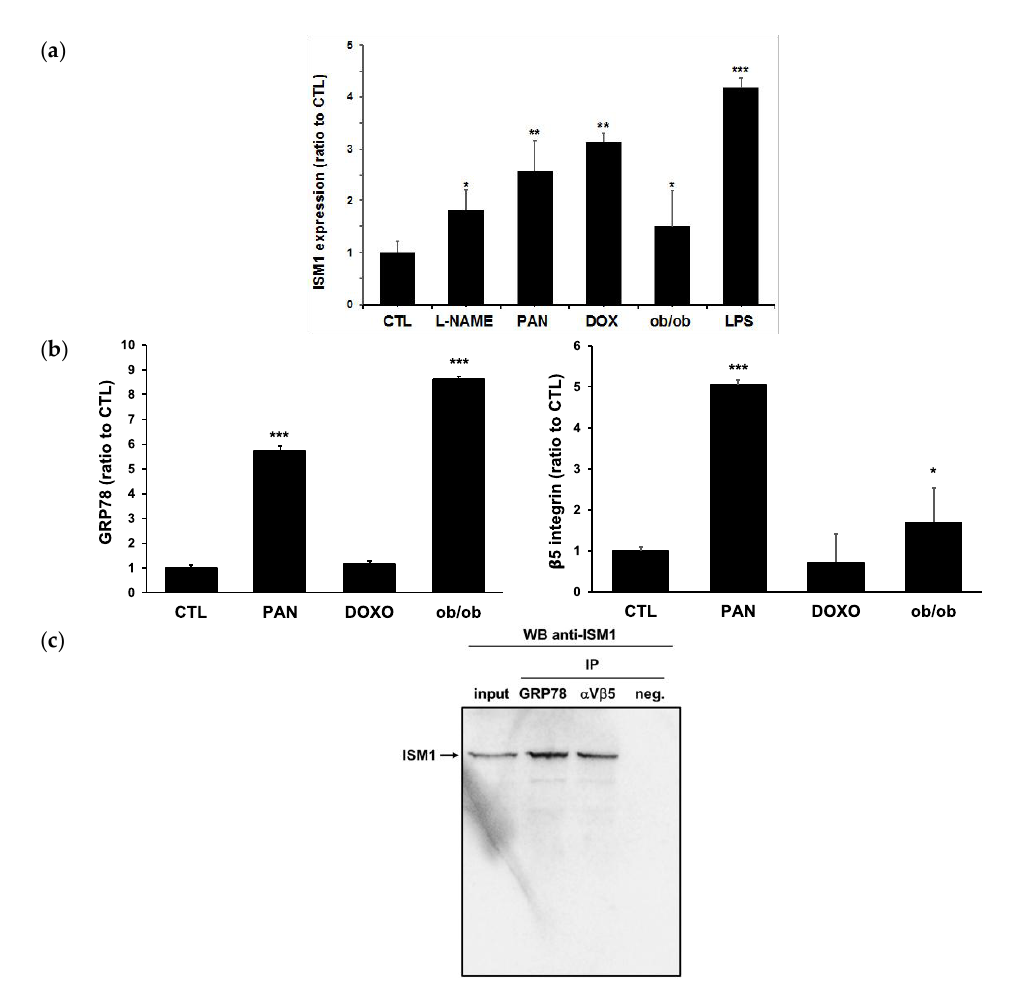
Figure 4. Expression of ISM1 and its receptors in different models of glomerulopathies. Estimation by RT-qPCR ( n = 6): ( a ) ISM1 expression in different models of proteinuria (L-NAME (W0), doxorubicin, puromycin, obesity, and LPS. Values normalized to CTL; ( b ) Expression of GRP78 (left) and integrin-β5 (right) in doxorubicin, puromycin, and obesity models. *, p < 0.05 vs CTL **, p < 0.01 vs CTL ***, p < 0.001 vs CTL ( c ) Interaction between ISM1 and its GRP78 and integrin αvβ5 receptors in cultured podocytes. Immunoprecipitation (IP) of GRP78 and integrin αvβ5 using podocyte cells and then, Western blot of ISM1. Negative control with unspecific antibody. The ISM1 interacts with its receptors in podocytes, in basal conditions, ( n = 2).